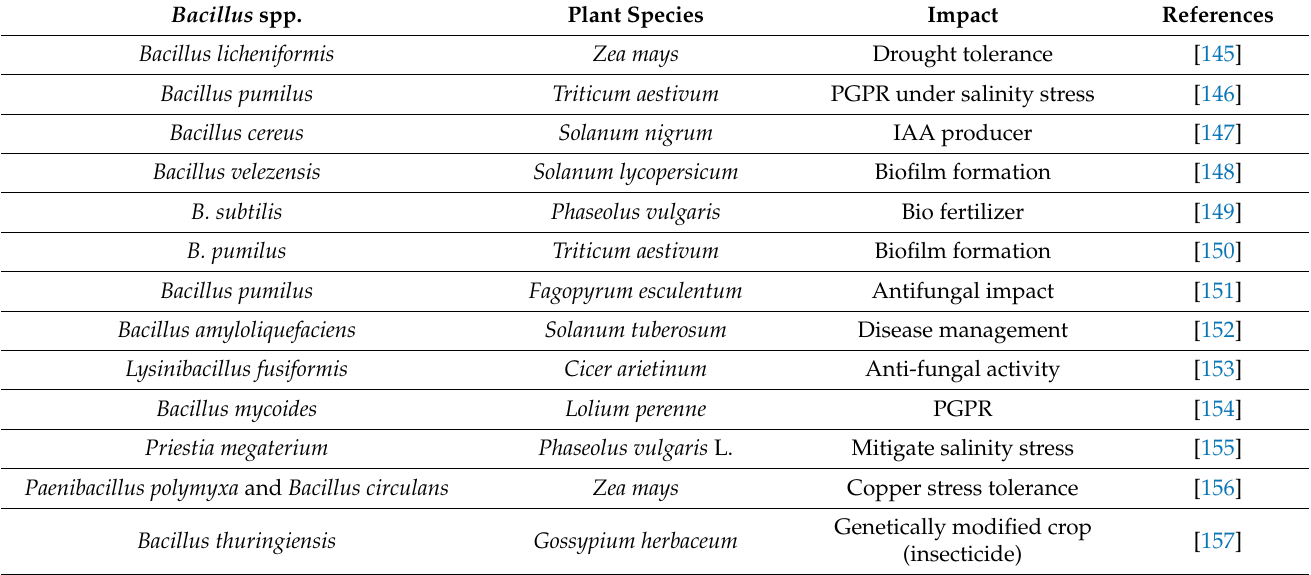
Table 2. Multifaceted impacts of Bacillus sp. on various crops grown under various stress conditions. Bacillus